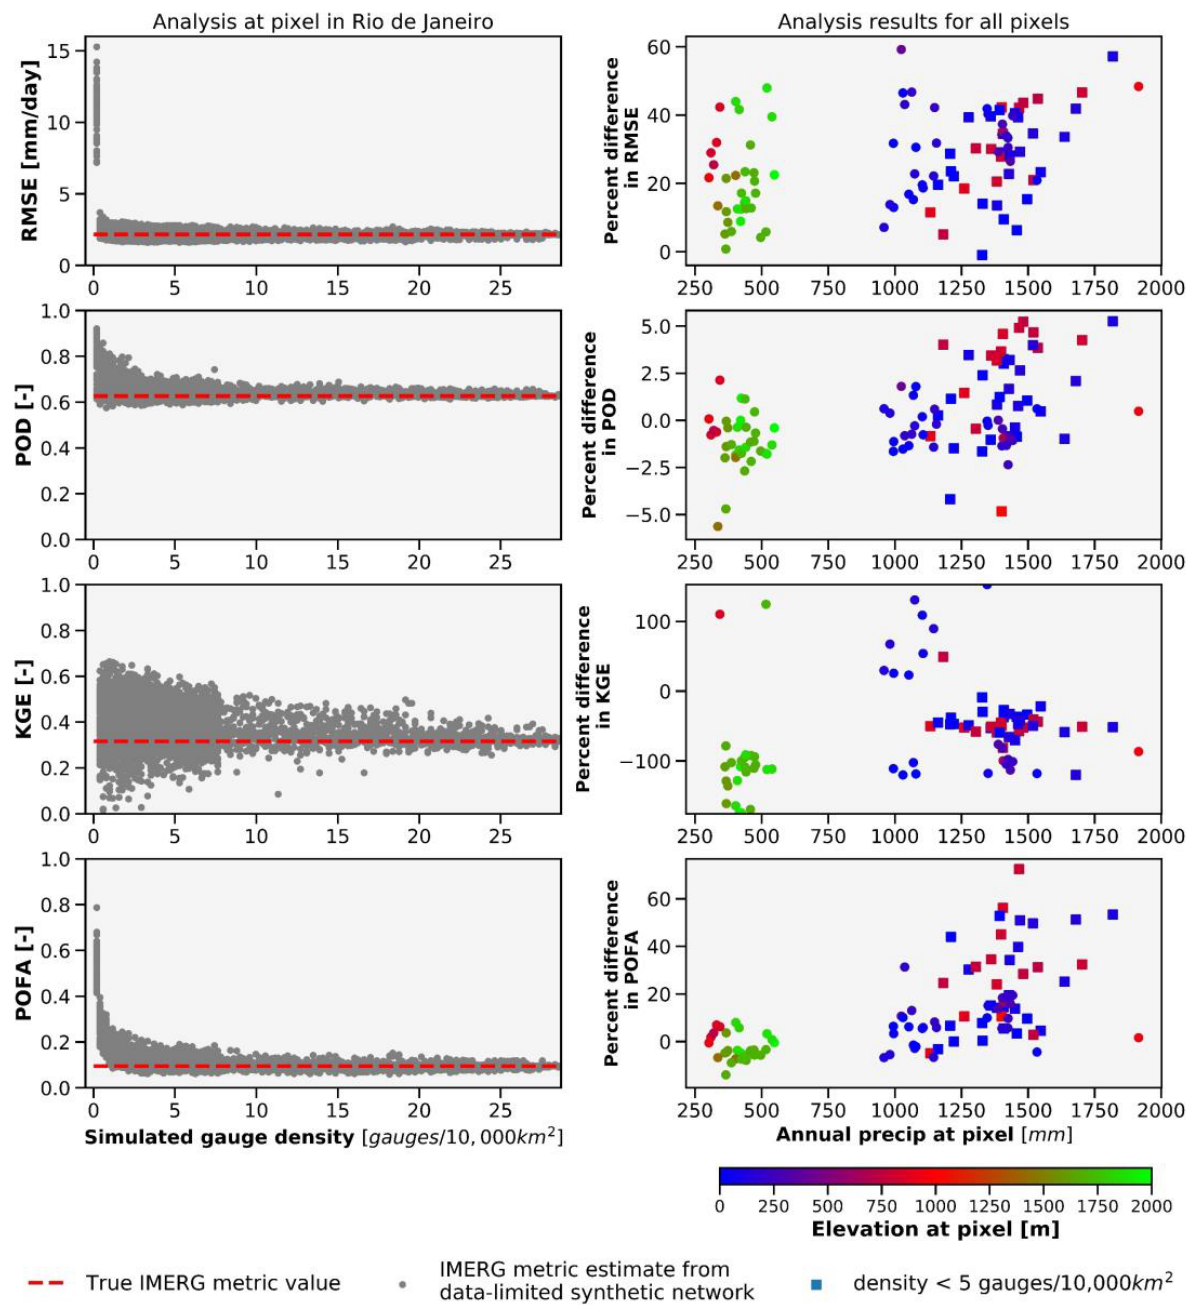
Figure 7. ( Left column ) Example of IMERG-Early RMSE, POD, KGE, and POFA assessed using data-limited simulations at a pixel in Rio de Janeiro. ( Right column ) Average percent difference between metrics estimated using data-limited interpolations with gauge density less than 5 gauges/10,000 km 2 and the true IMERG metric. Positive percent difference values in right column indicate that data-limited interpolations are overestimating an error metric for IMERG.